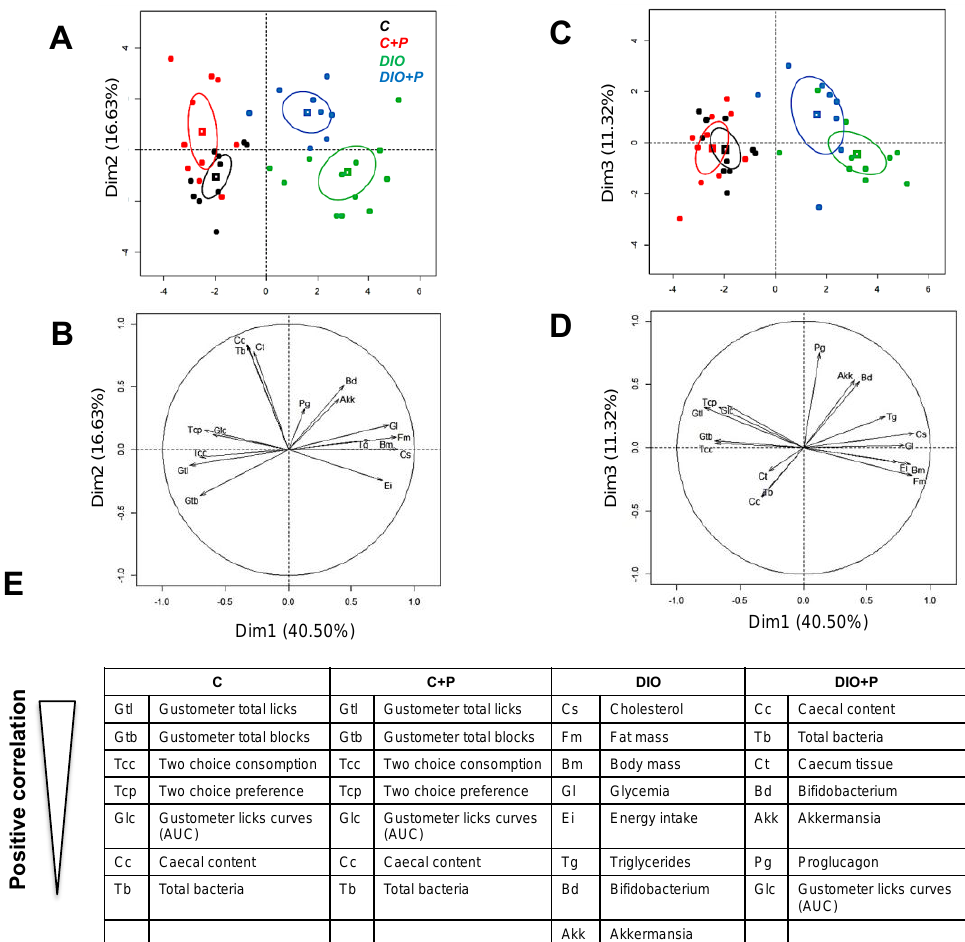
Figure 6. Principal component analysis performed from studied variables in mice subjected to a regulatory chow or an obesogenic diet alone (C and DIO) or supplemented with 10% Prebiotic (C+P and DIO+P). ( A ) Confidence ellipse analysis. Cluster distribution along the dimension 1 & 2. Each dot represents a mouse; ( B ) Arrows represent the direction of each variable in the 2-dimensional PCA space; ( C ) Cluster distribution along the dimension 1 & 3. Each dot represents a mouse; ( D ) Arrows represent the direction of each variable in the 2-dimensional PCA space; ( E ) Variables significantly representative of the 4 clusters (ranking in descending order of importance) and their respective abbreviations.